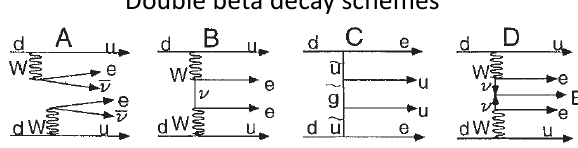
Figure 1. Schematic diagrams for 2 neutrino double beta decay (DBD) ( A ) and for neutrinoless DBDs with a Majorana neutrino exchange ( B ), the SUSY particle exchange ( C ) and the Majoron emission ( D ). DBD processes with 2 neutrons → 2 protons in the DBD nucleus are shown. d and u are d and u quarks in the 2 neutrons and the 2 protons, respectively